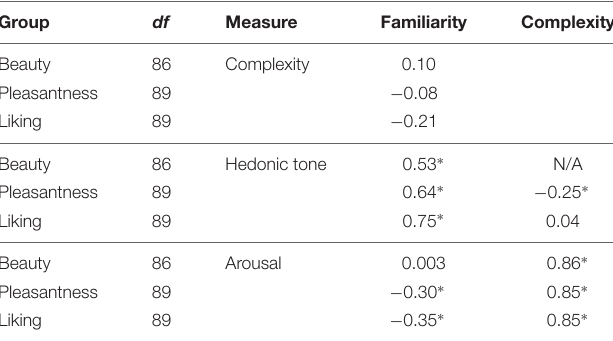
TABLE 8 | Spearman’s rank order correlations between measures of familiarity, complexity, arousal and measures of hedonic tone in response to 19th-century piano solo